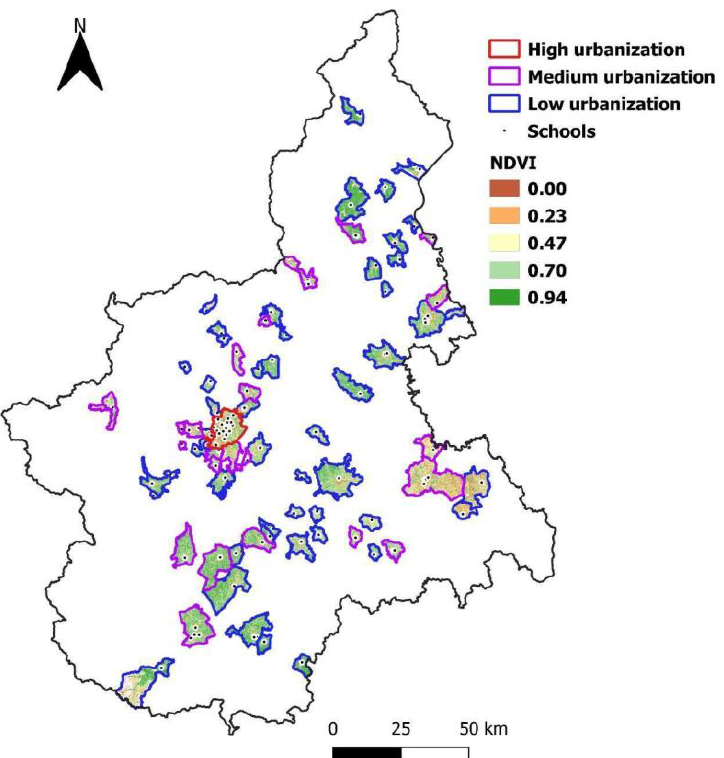
Figure 1. Geolocalization of 2018 HBSC schools in the Piedmont region and their results in NDVI and urbanization levels. Abbreviations: NDVI = Normalized Difference Vegetation Index. Urbanization classification: high = cities; medium = towns and suburbs; low = rural areas.